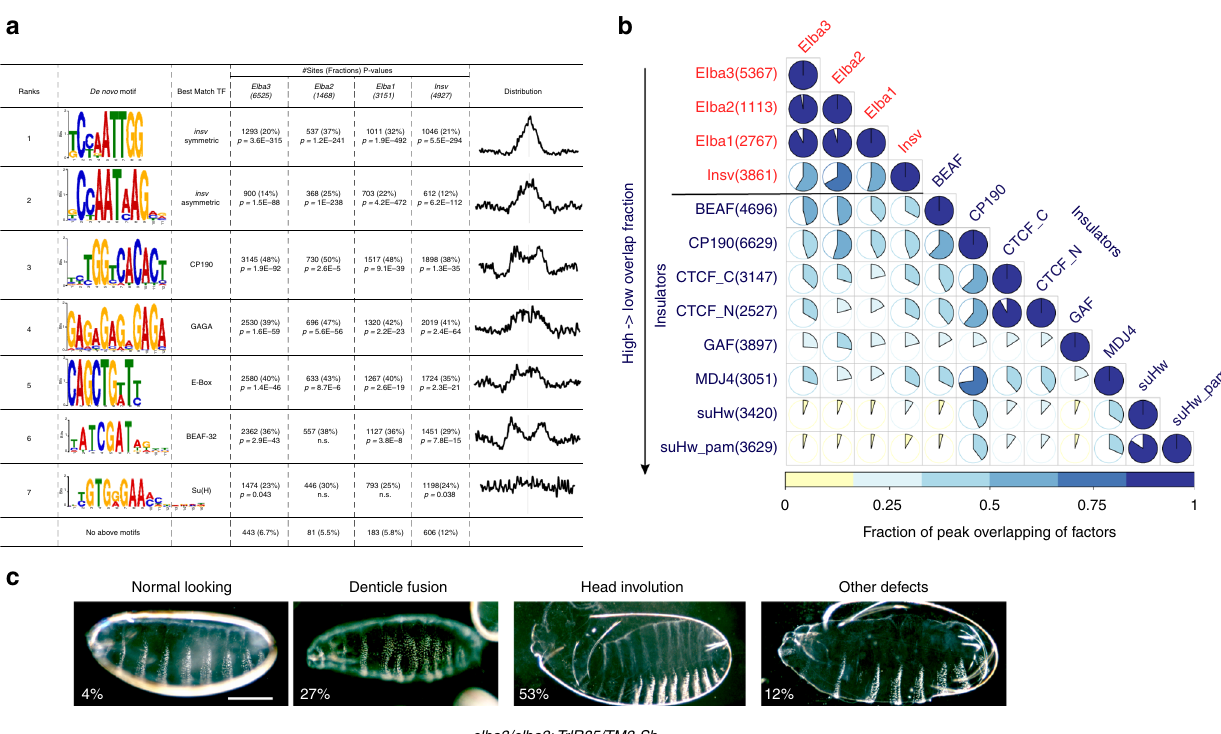
Fig. 5 Interaction of ELBA and Insv with other insulator proteins. a The de novo motif discovery analysis from the Elba and Insv peaks identi fi ed the Insv/ ELBA symmetric and asymmetric motifs, motifs for CP190, GAF, and BEAF-32, E-box and the Su(H)-binding site. b The pairwise peak overlapping matrix summarizes the genomic co-occupancy of the ELBA factors, Insv and six known insulator proteins (see Methods). Among these insulator proteins, CP190 exhibits the highest overlap with ELBA and Insv, followed by BEAF-32 and CTCF. ELBA and Insv have the least overlapping with GAF, Mod(Mdg4), and Su (Hw). c Representative images of cuticle preps from the mutants for the ELBA factors and Trl (GAF) or CP190 . The percentages are shown for animals with the elba3 homozygous with the Trl R85 heterozygous mutations. Scale bar: 100 µ m. Source data of phenotypic quanti fi cation is available in a Source Data fi le.